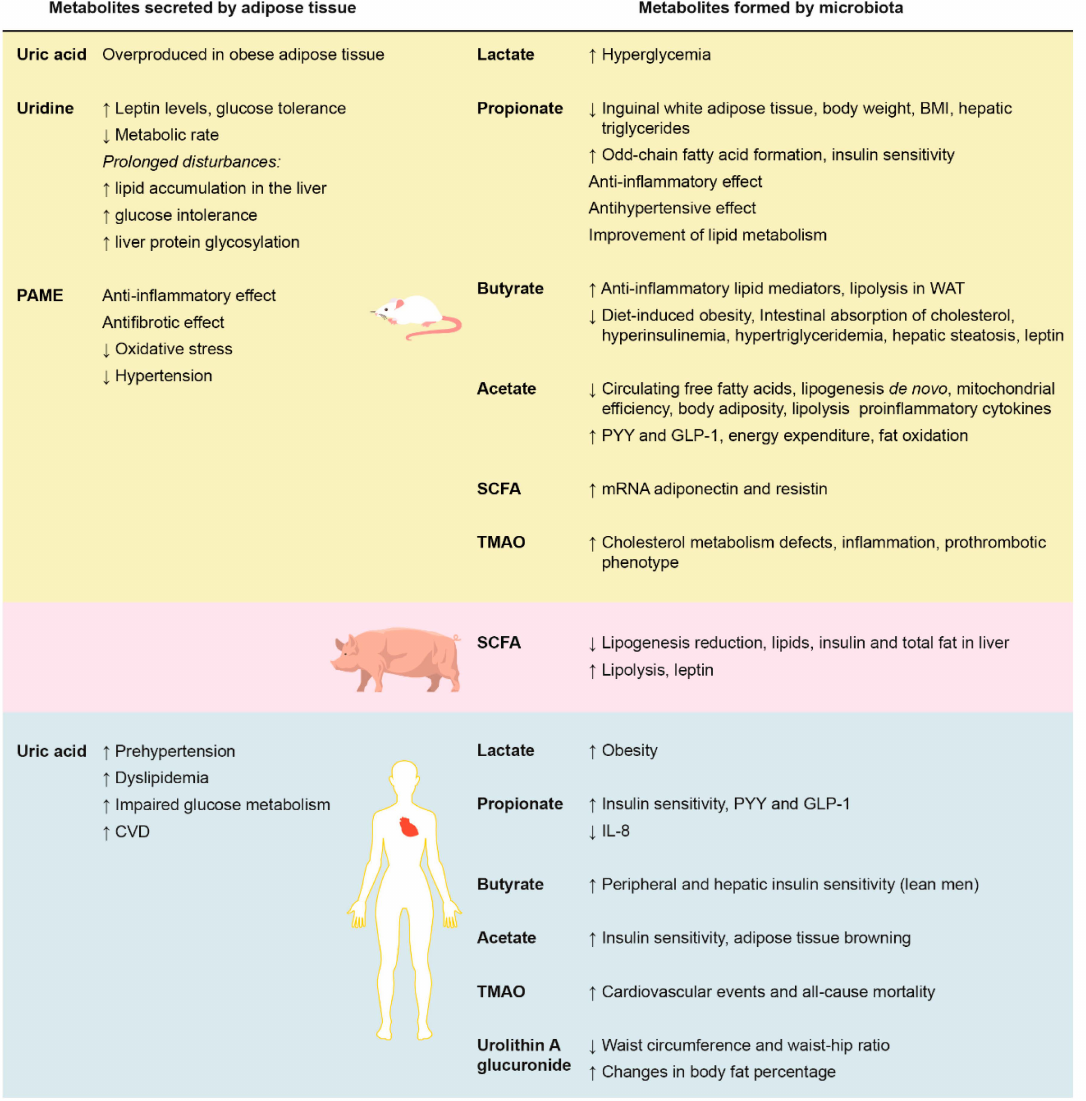
Figure 1. E ff ects of adipose tissue-secreted metabolites ( left ) and microbiota-formed metabolites ( right ) on rat, pig, and human metabolisms on adipose tissue and cardiovascular system parameters. BMI: body mass index; CVD: cardiovascular diseases; GLP-1: glucagon-like peptide-1; IL-8: interleukin 8; PAME: palmitic acid methyl ester; PYY: peptide YY; TMAO: trimethylamine N-oxide; WAT: white adipose tissue. ↑ : increase; ↓ :